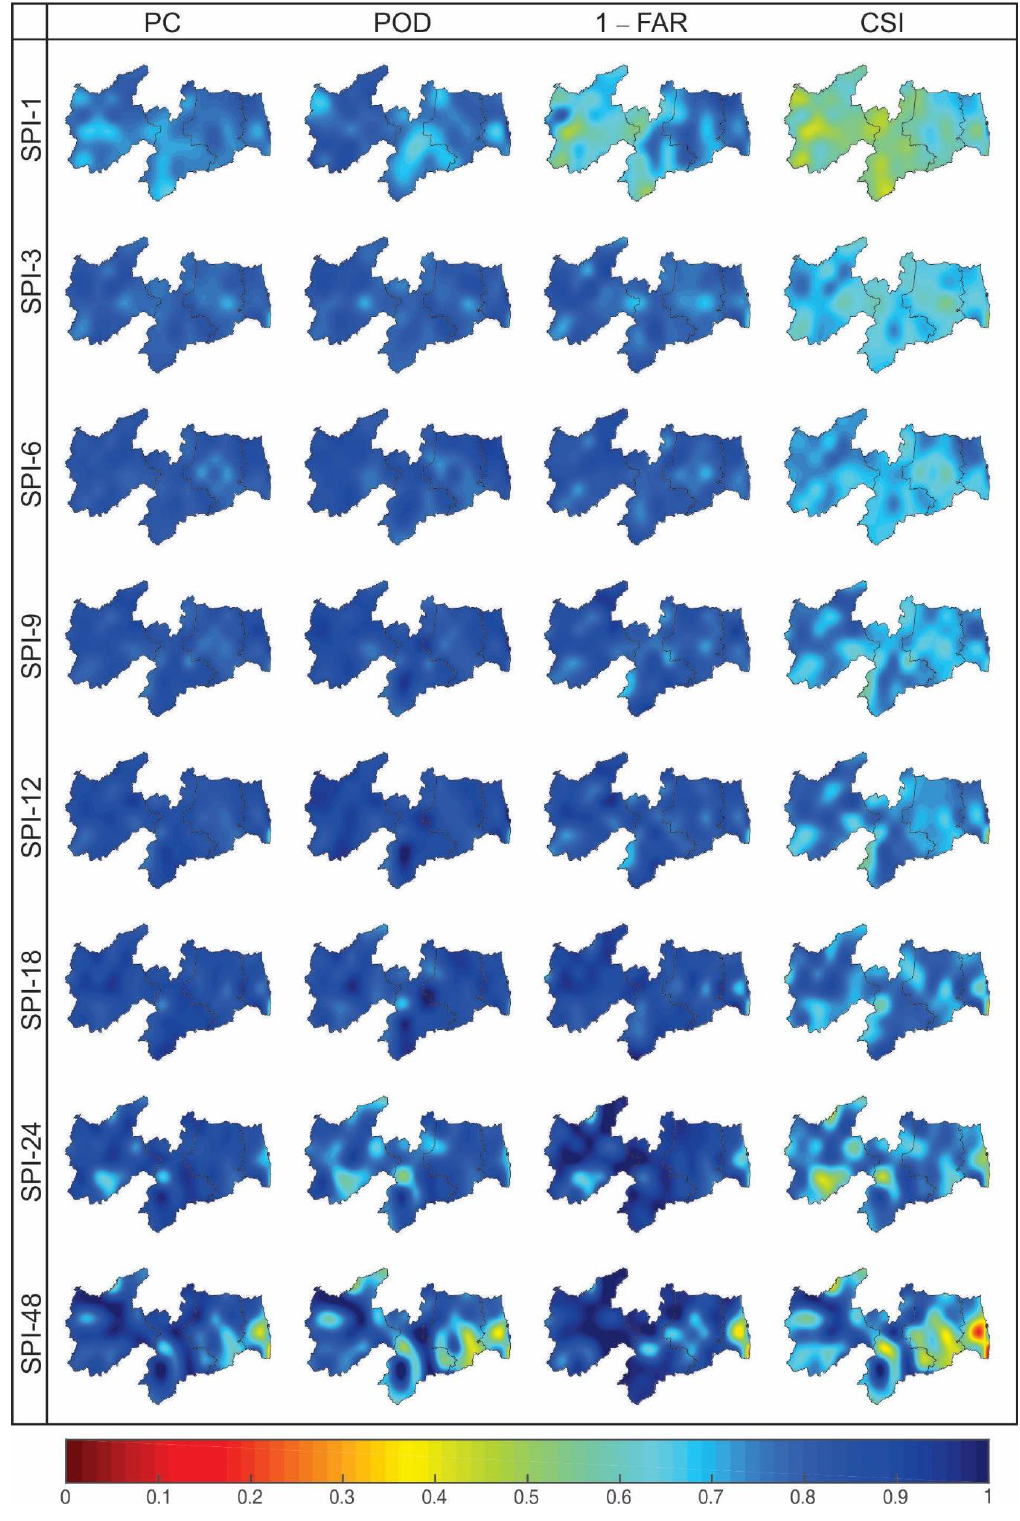
Figure 7. Spatial distribution of the PC , POD , (1 − FAR ) and CSI indices in Para í ba